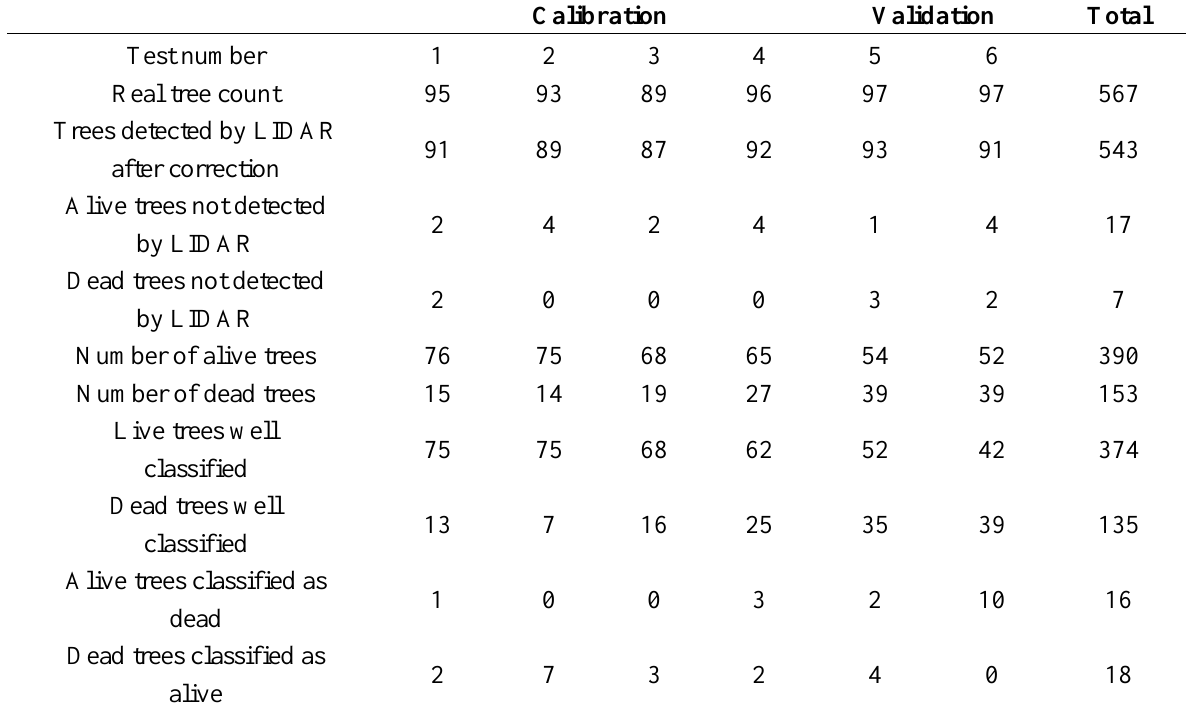
Table 9. LIDAR results obtained for the tree classification with the calibration and validation samples using the parameter values selected in the calibration (dead range of 55 and threshold count of 11.75).